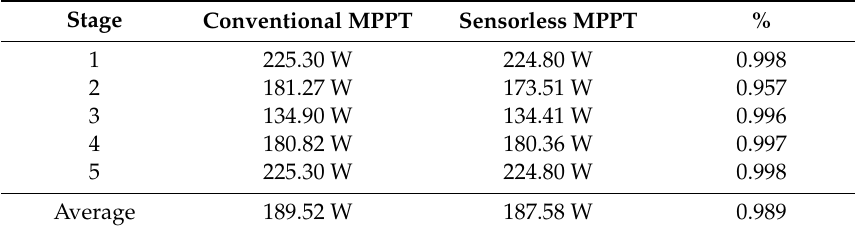
Table 6. Transient radiation test